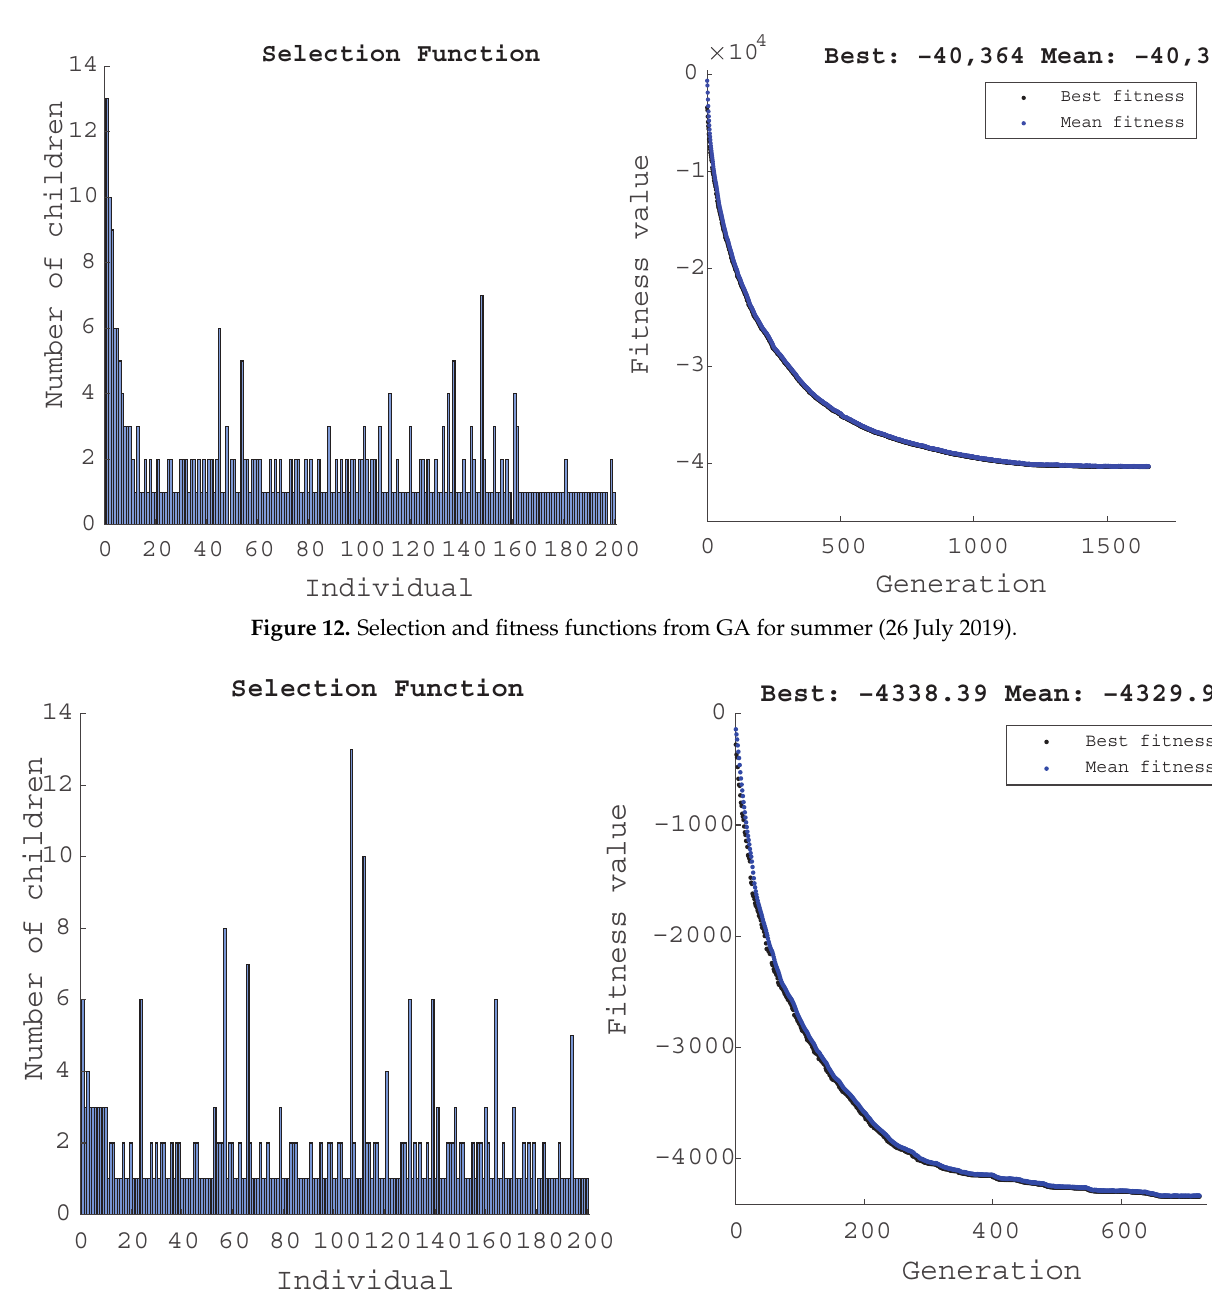
Figure 13. Selection and fitness functions from GA for fall (10 September 2019). The results obtained from GA are shown in Figure 15a,b for the SoC (BESS: min—20% and max—90%) and SoE (TESS: min—0% and max—95%) of both the BESS and TESS, respectively. The depth of discharge is different for the two storage systems, which can be observed from charge and discharge profiles as shown in Figures 16 and 17. The thermal storage system discharges fully to zero, whereas the battery storage system’s minimum discharge limit is 20% of the total capacity. Internal losses are comparatively